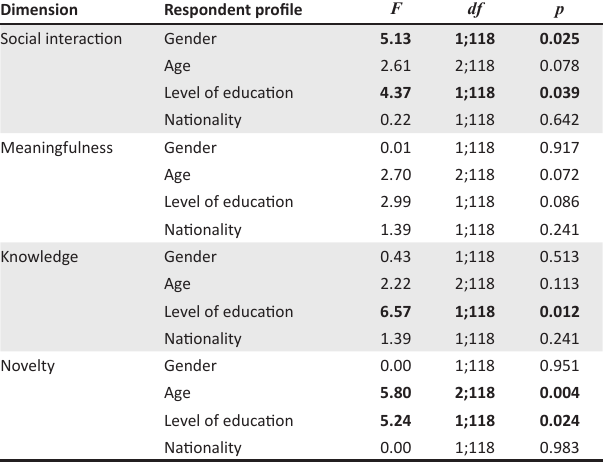
TABLE 7: Differences in perceptions of cognitive dimensions based on profile variables: Whale-watching. Dimension